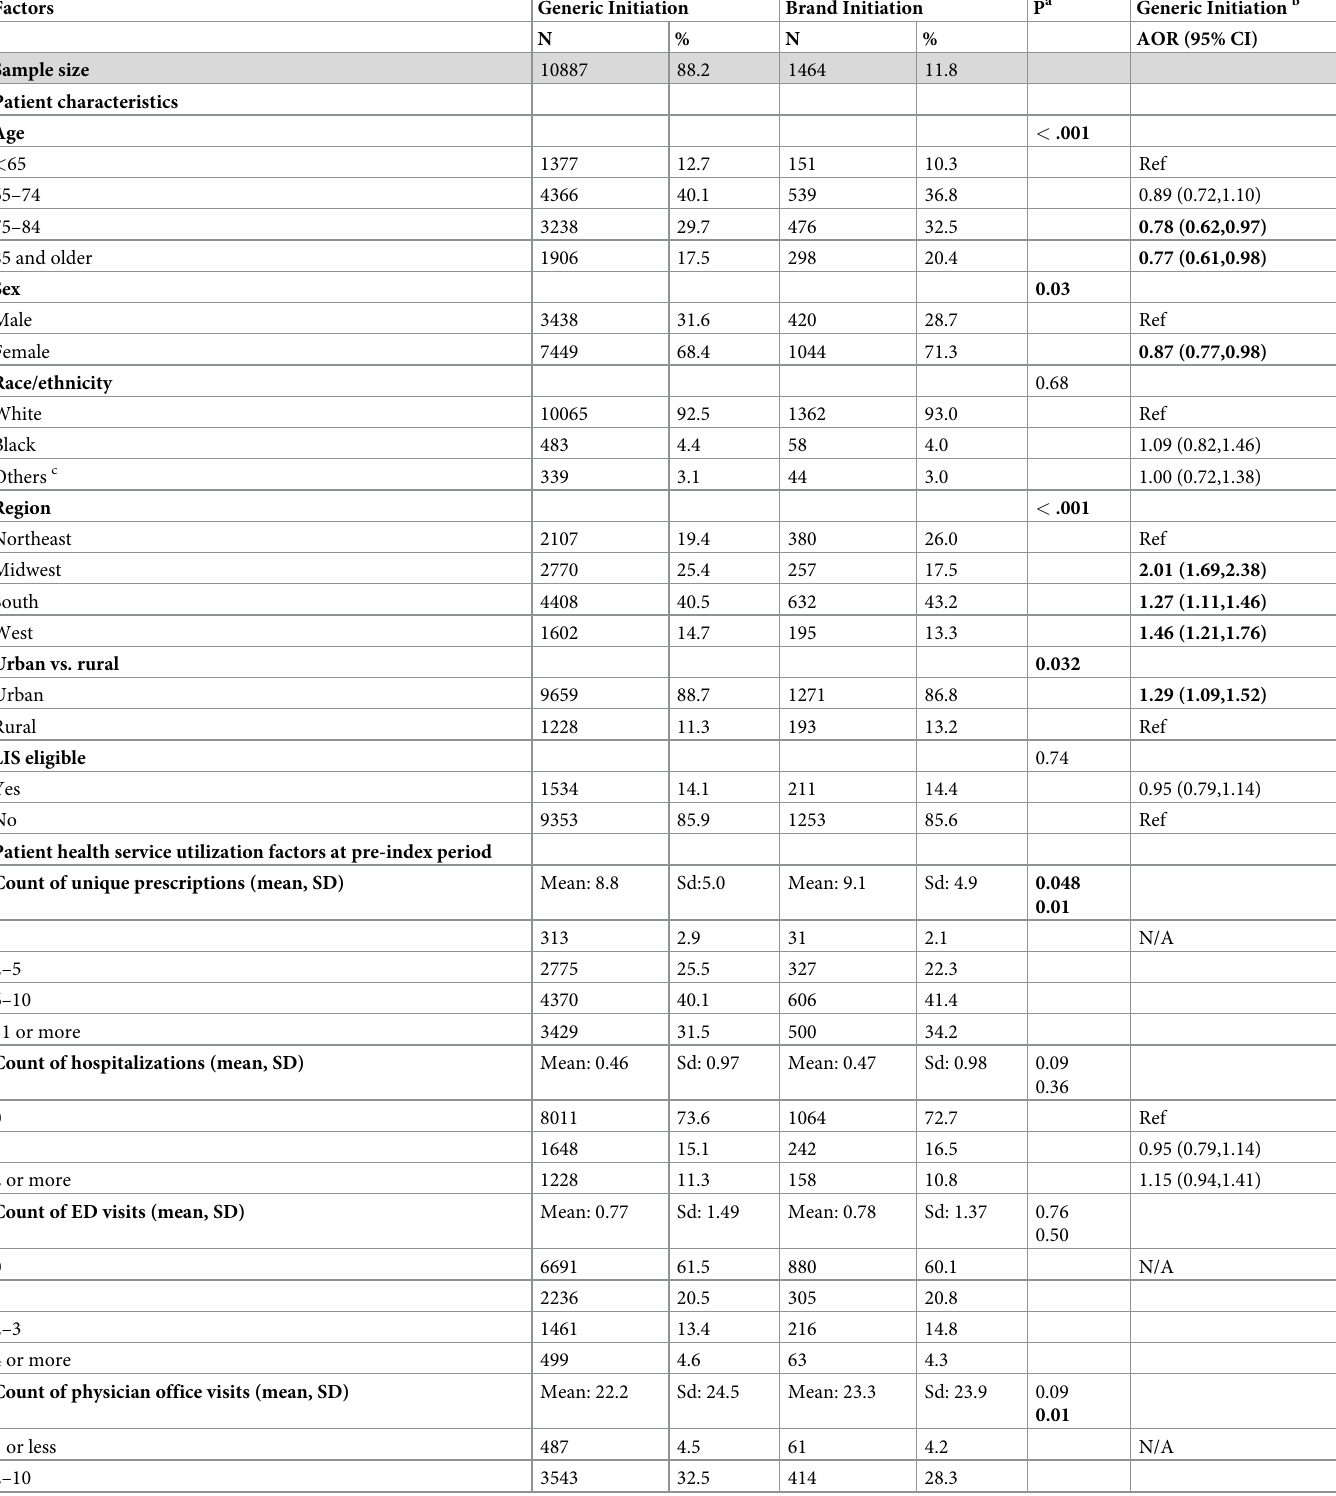
Table 1. Sample characteristics and factors associated with generic escitalopram initiation (n =